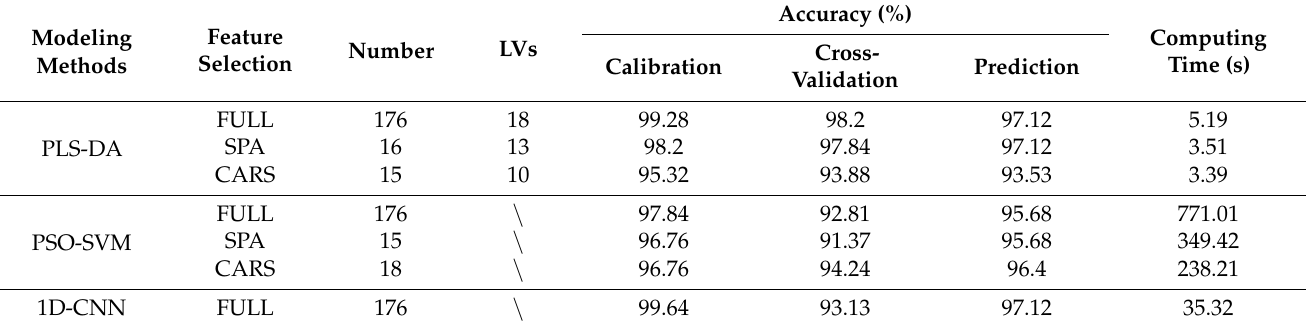
Table 7. Comparison of performance obtained with machine learning methods based on feature selection.